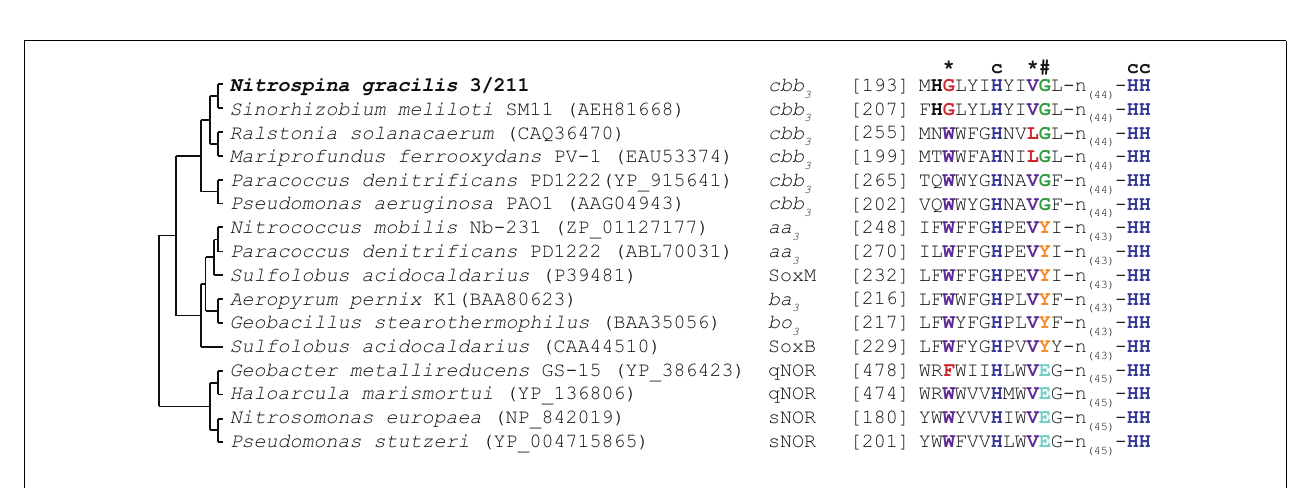
FIGURE 4 | Partial multiple sequence alignment of selected heme-copper oxidase-family members. Relationship of the enzymes is indicated by a cladogram.The oxidase type is indicated for each enzyme. Amino acid residues involved in the formation of the copper (Cu B )-binding site are highlighted in color and by a symbol indicating function: dark blue, histidine